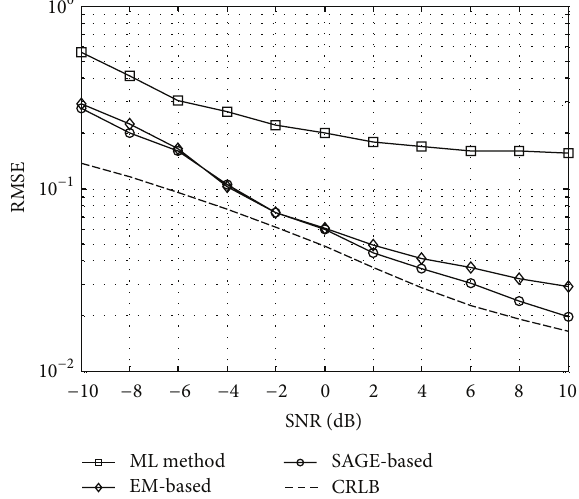
Figure 5: RMSE of sensor location error of different methods against SNR.